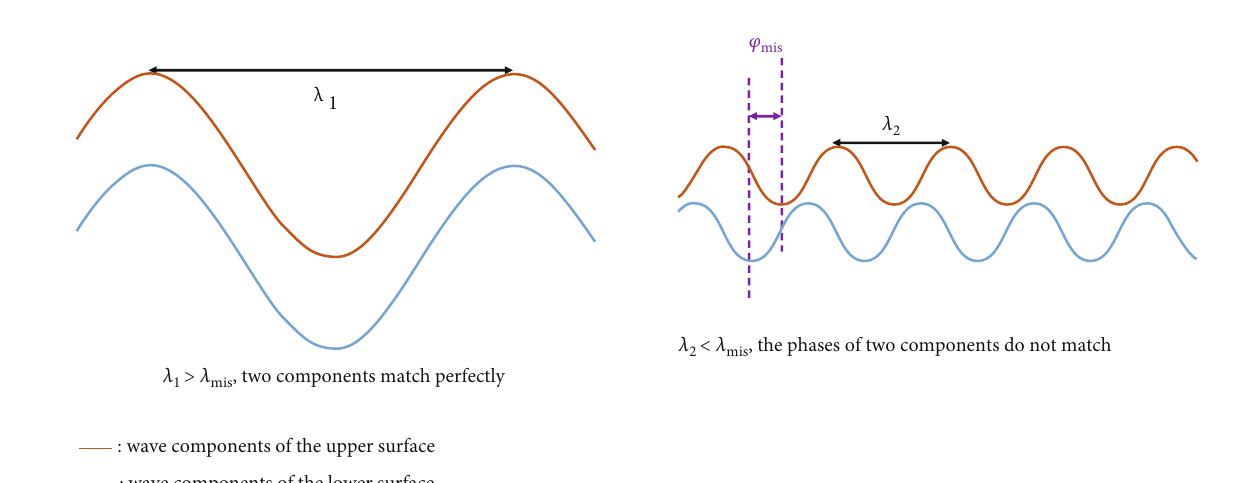
. (a) Degree of correlation with respect to the mismatch length, λ mis , λ , and λ represent three di ff erent wavelengths. For the left wave components, 1 2 mis represents the mismatch in phase between the two components. mis